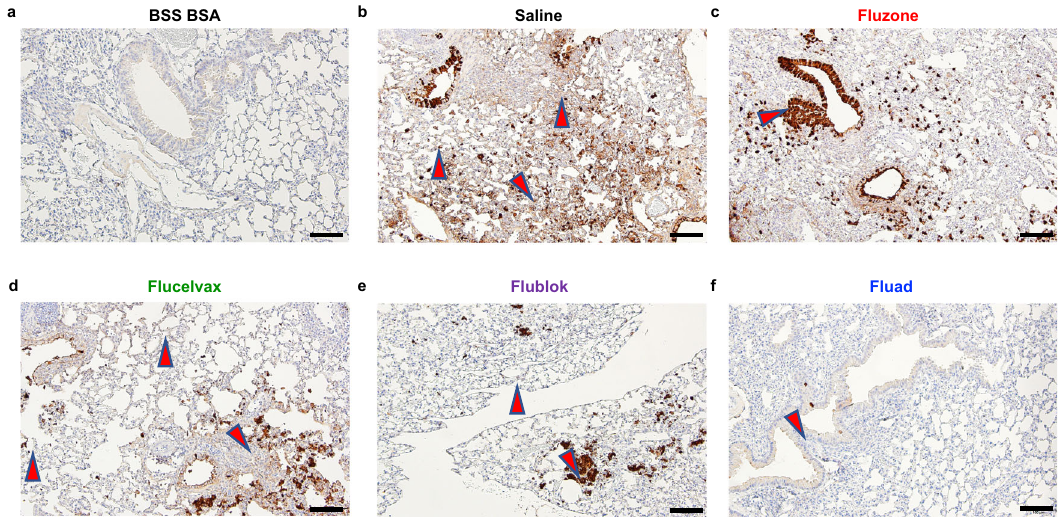
Fig. 7 | Histopathology in mice lungs following vaccination with commercial in fl uenza vaccines and subsequent challenge with H1N1 in fl uenza virus. a – f Imagesshow immunohistochemistry(IHC)against the in fl uenza nucleoprotein protein for different vaccination groups. Red arrows denote viral antigen areas. Images shown are from day 3 post H1N1 challenge for all groups. a Healthy lung control via immunization with saline and challenged with saline-BSA. b Pathogenic